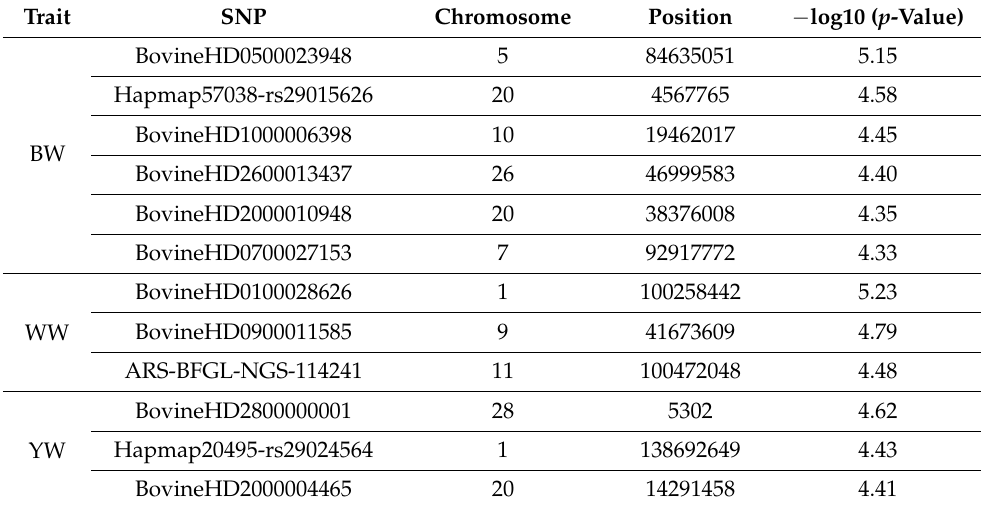
Table 3. Results of significant additive SNP effects from genome wide association study of growth